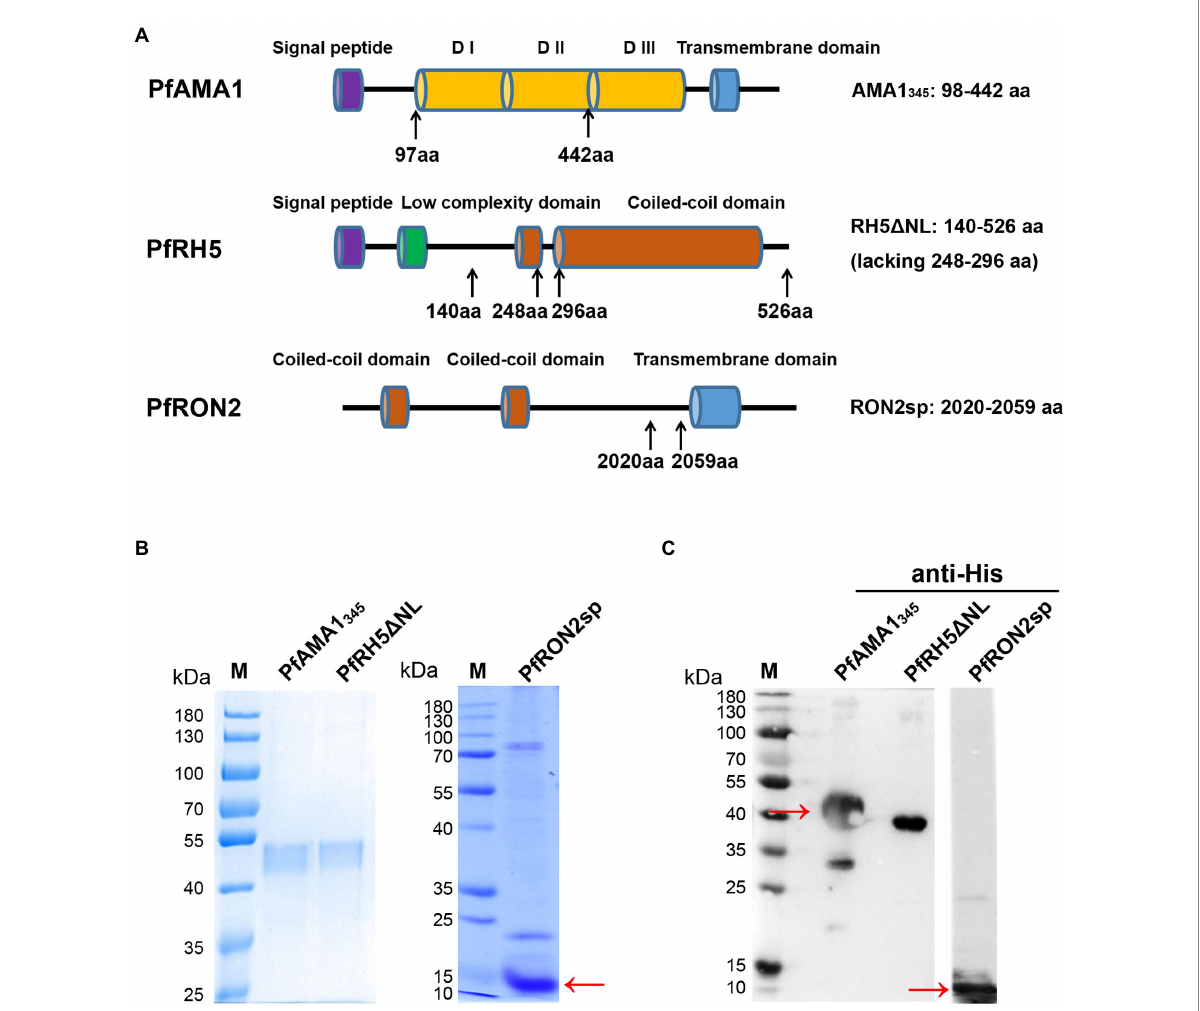
FIGURE 1 Construction, expression, and purification of recombinant PfAMA1 345 and PfRH5 Δ NL proteins, as well as synthesis and identification of PfRON2sp. (A) Schematic representation of PfAMA1, PfRH5, and PfRON2. The signal peptide is shown in purple, domain I/ domain II/ domain III (D I/D II/D III) in orange, the transmembrane domain in blue, the low complexity domain in green, and the coiled-coil domain in red. The genes encoding PfAMA1 345 (98-442aa) and PfRH5 Δ NL (140-526aa, lacking 248-296aa) were cloned for expression and purification. PfRON2sp (2020-2059aa) peptide was synthesized. The amino acid residue of PfAMA1 345 , PfRH5 Δ NL, and PfRON2sp were shown in the right panel. (B) Expression and purification of PfAMA1 345 and PfRH5 Δ NL proteins. Codon-optimized PfAMA1 345 and PfRH5 Δ NL genes were cloned in the pET28a (+) vector, transformed in E. coli , and purified using Ni-sepharose beads. The purified PfAMA1 345 , PfRH5 Δ NL, and PfRON2sp peptides were separated by SDS- PAGE and stained using Coomassie brilliant blue (B) and immunoblotting with anti-His antibody for PfAMA1 345 , PfRH5 Δ NL, and anti-RON2 for PfRON2sp (C)